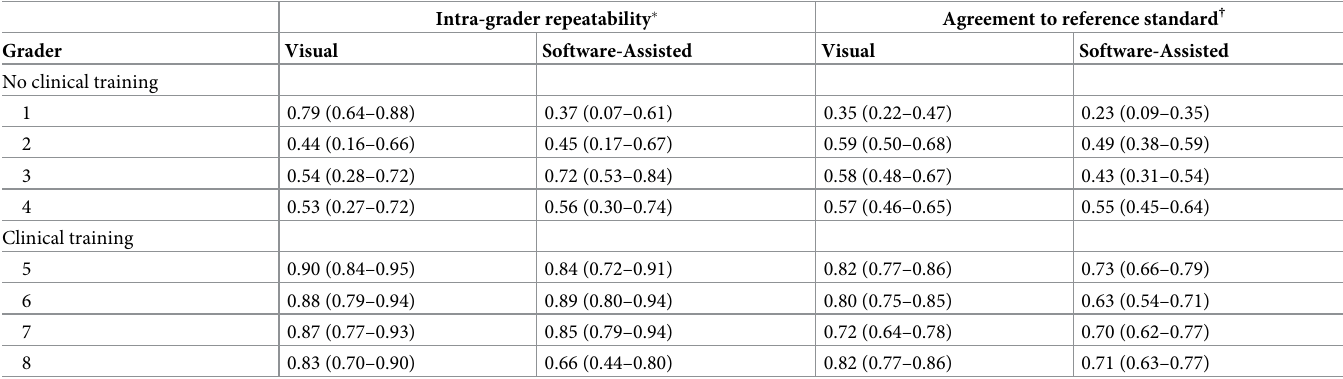
Table 1. Repeatability and validity of visual inspection and software-assisted determination of the vertical cup-to-disk ratio (VCDR) by